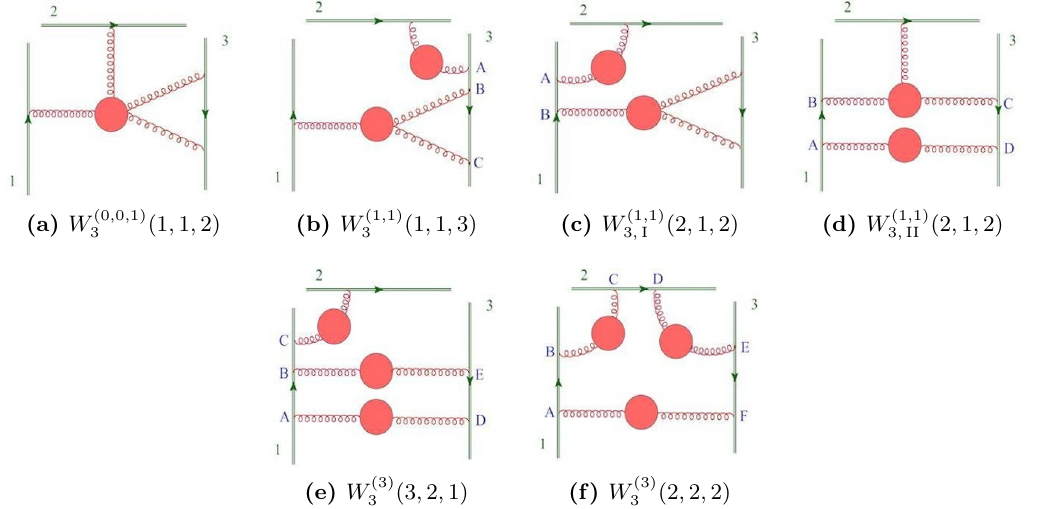
Figure 7. Representative skeleton diagrams for the six non-vanishing Cwebs in a massless theory connecting three Wilson lines, and whose perturbative expansion starts at O ( g 6 ). Their respective numbers of skeleton diagrams are f 1 ; 3 ; 2 ; 4 ; 6 ; 8 g